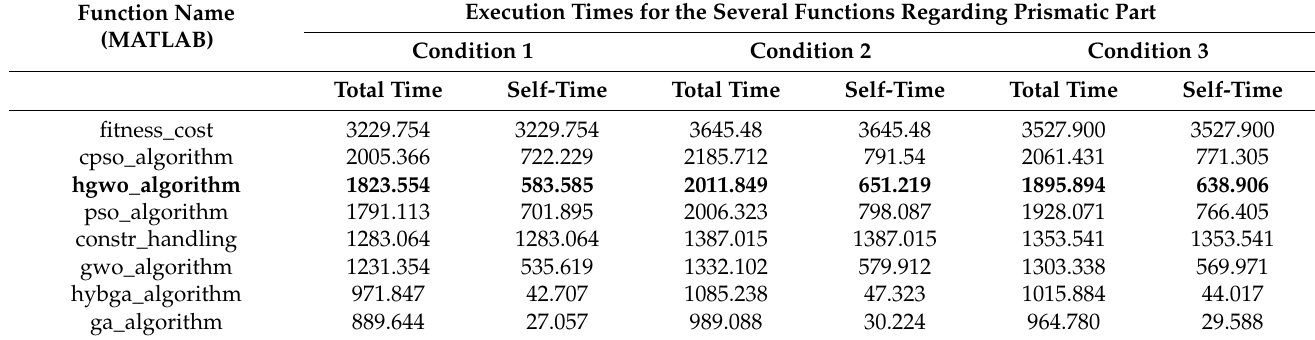
Table 13. MATLAB profile summary report about the execution times of certain MATLAB